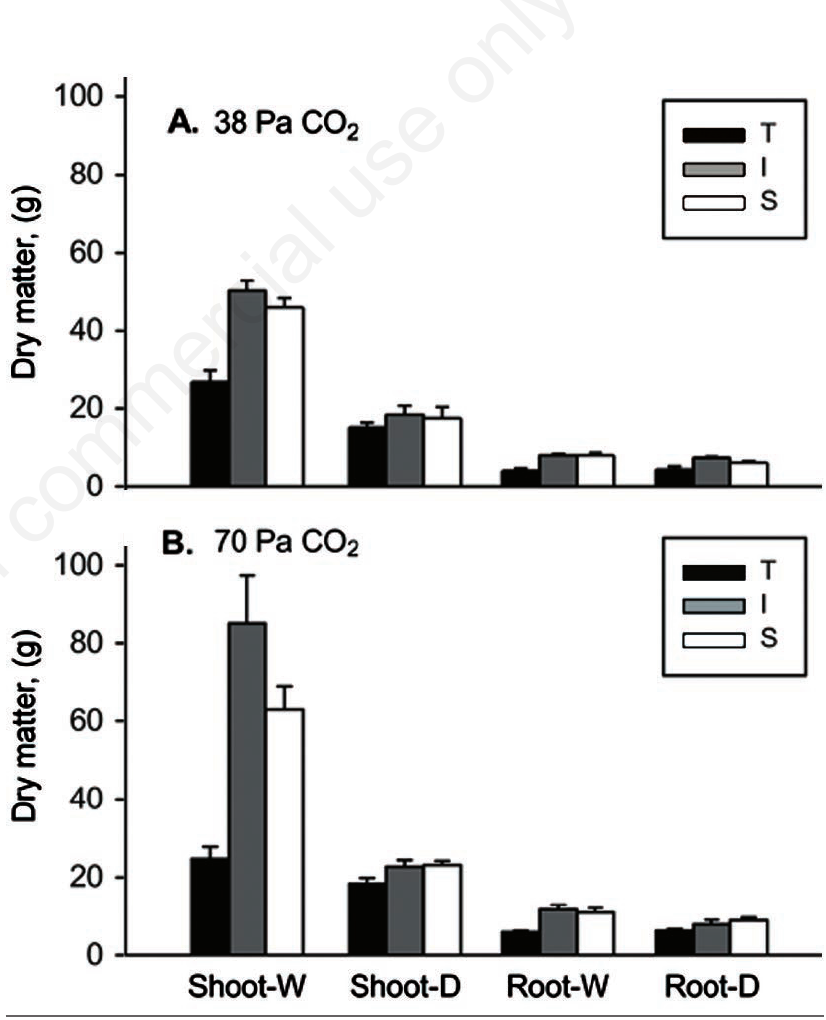
Figure 1. Dry matter accumulation of three maize hybrids differing in drought resistance. Drought treatments were applied to 17 d old sensitive (gray fill), intermediate (black fill) and drought tolerant (light gray fill) maize hybrids. Shoot (left two columns) and root (right two columns) dry matter (g) was measured after 17 (ambient, Panel A) or 19 (ele- vated, Panel B) d of drought treatment. Values are means ± standard error for eight sam- ples from two fully replicated